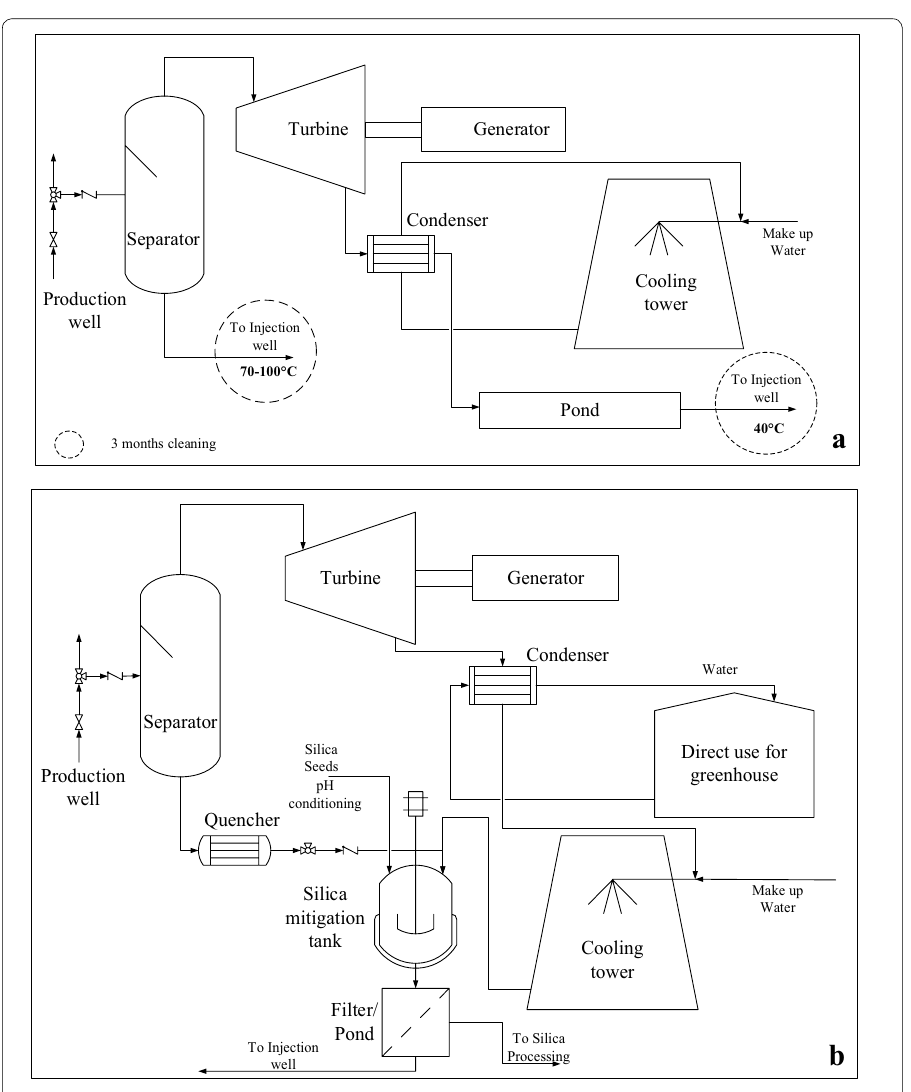
Fig. 8 A flow diagram process (FDP) a existing and b to mitigate and utilize geothermal